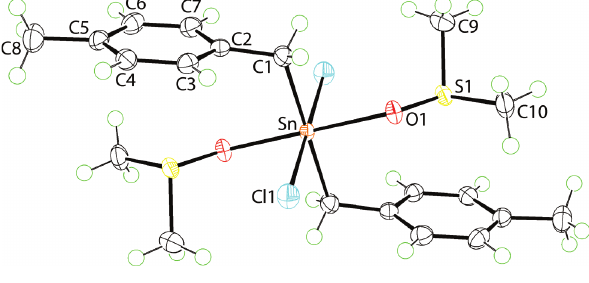
Table 1: Data collection and handling.